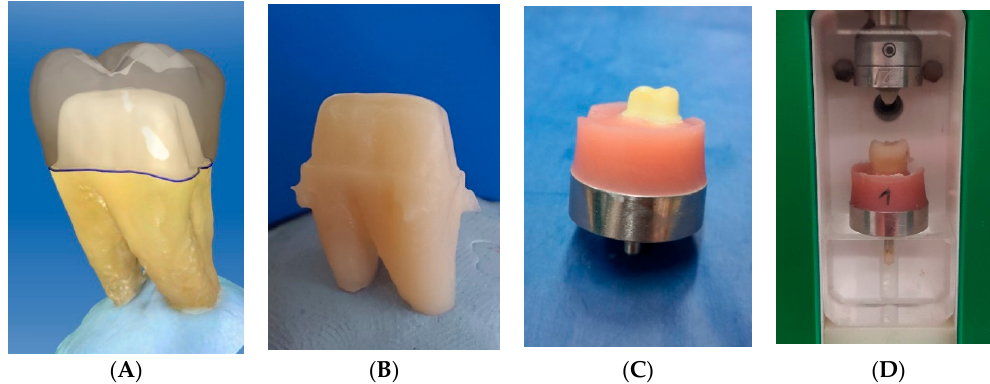
Figure 1. Preparation of specimens for fractural loading: ( A ) original prepared tooth with overlain biocopy crown; ( B ) hybrid ceramic (VITA ENAMIC; 2M2HT; Vita Zahnfabrik, Bad Säckingen, Germany) replica die of original preparation including root morphology; ( C ) specimen embedded in metal carrier with polymethyl methacrylate; and ( D ) thermo-mechanical load cycling in chewing simulator with human molar cusps as antagonists.